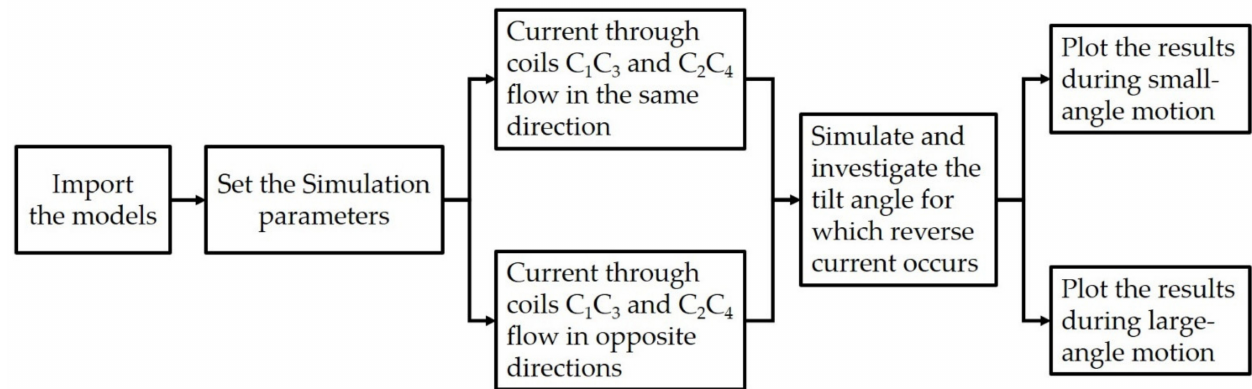
Figure 7. The plan of the simulations of the proposed 3-DOF spherical